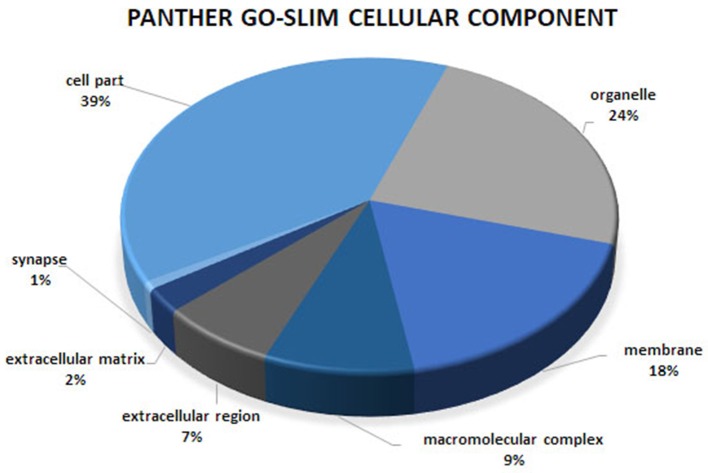
Cellular component analysis of the co-association network for meat quality complex. The PANTHER overrepresentation test grouped 609 annotated genes into 7 cellular components.